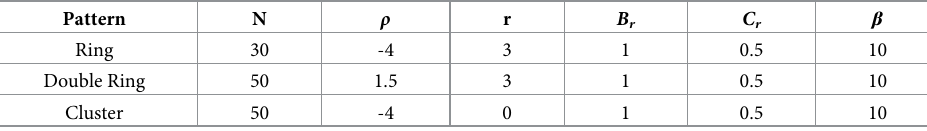
Fig 7. (a) Magnitude and phase of true y ( s ) and simulated output y (c) delay distribution of 50 insects and normalized Gaussian distribution.